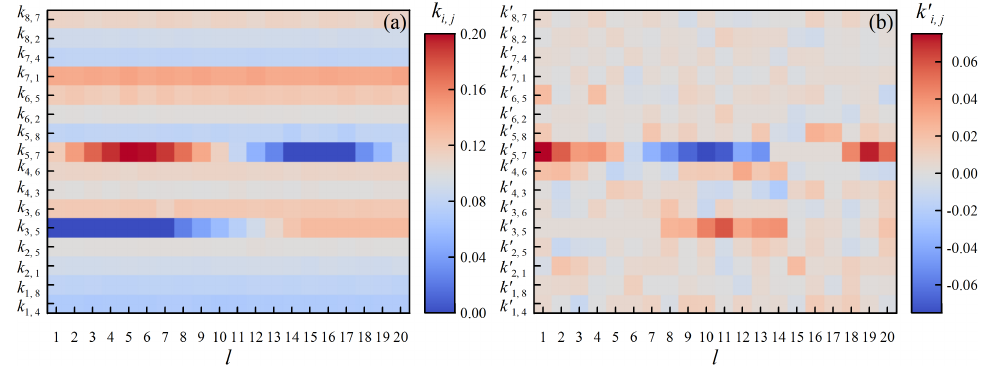
Figure 3. Reconstructed values of couplings coefficients. ( a ) Mean values k i , j of couplings (3) for different fragments l . ( b ) Slopes k (cid:48) of couplings (3) for different fragments l i , j